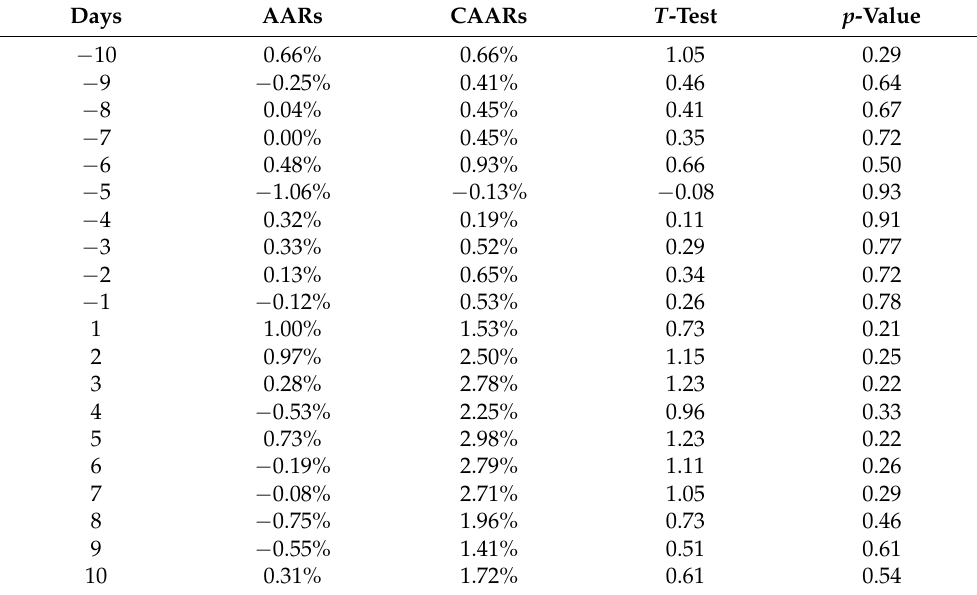
Table 1. Cross-border